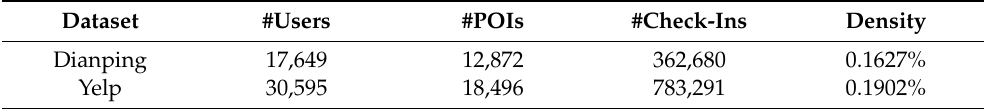
Table 1. The statistics of